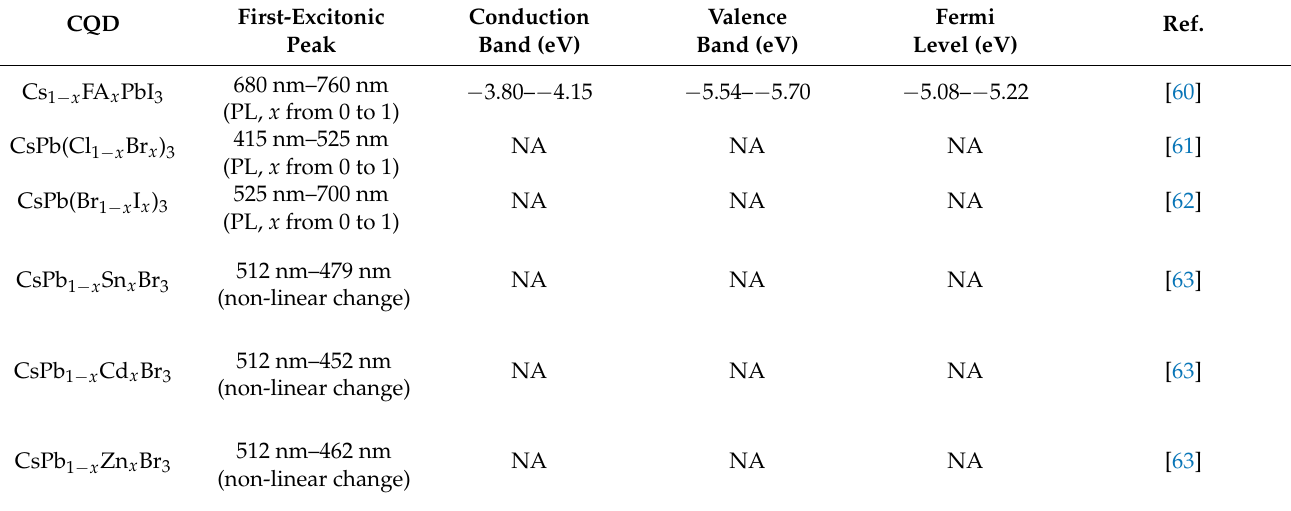
Table 3. Significant examples of the doping effect by post-treatment ion